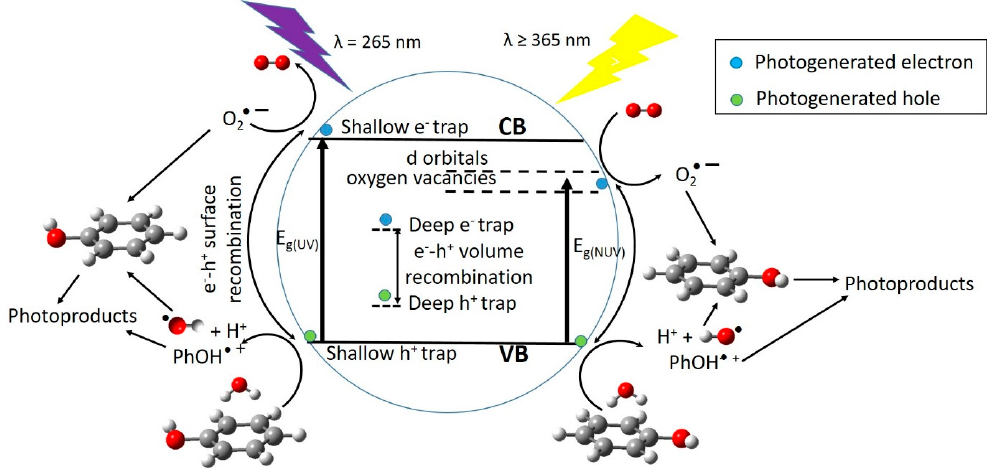
Figure 9. Processes involved in the photocatalyzed degradation of phenol with M(%) / TiO 2 -P25 under UV and near UV-Vis light (NUV-Vis) irradiation.